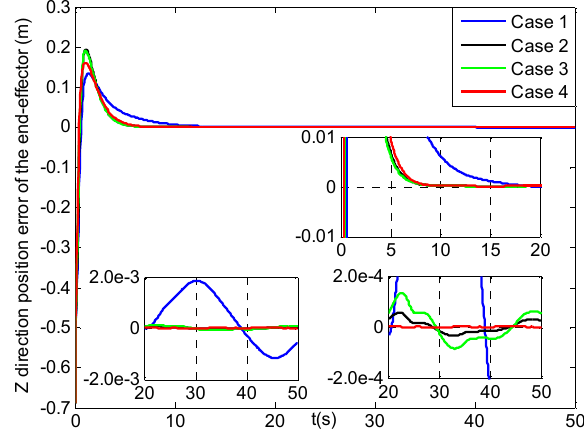
Figure 14. Z direction position errors of the end − effector (four cases).